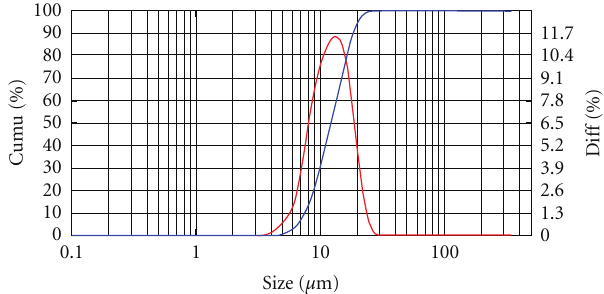
Figure 7: Particle size distribution of the prepared Li[Ni 0 . 5 Mn 0 . 3 Co 0 . 2 ]O 2